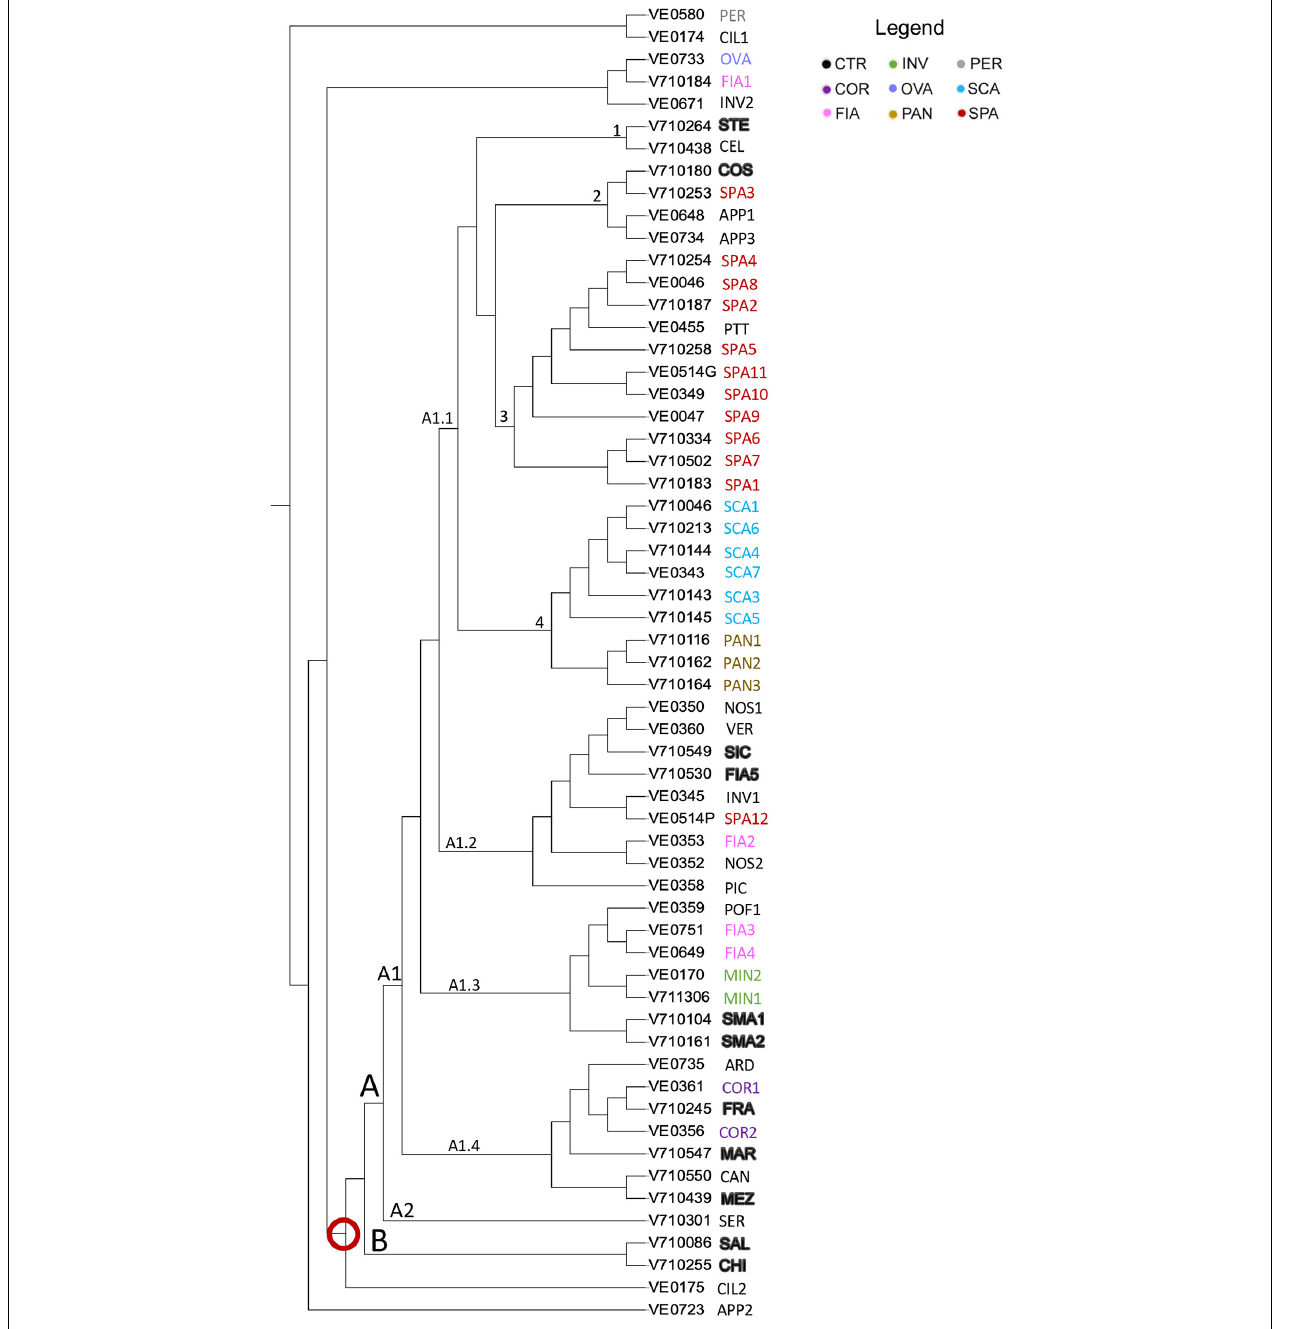
FIGURE 8 | Dendrogram of genetic relationships of 59 tomato accessions based on SNP. Neighbor-joining tree analysis generated by TASSEL; the different named accessions group and controls are indicated in different colors as in the legend; codes and abbreviations are listed in Supplementary Table 1 . Red ring indicated the main group of the entire